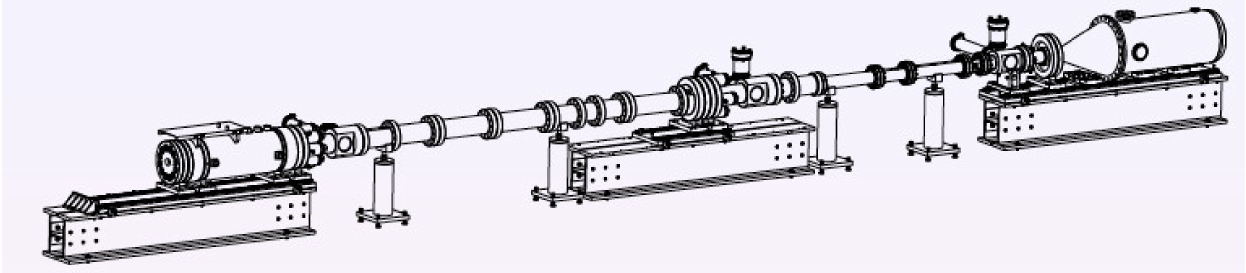
Figure 1. Sketch of ESTHER shock-tube (credit